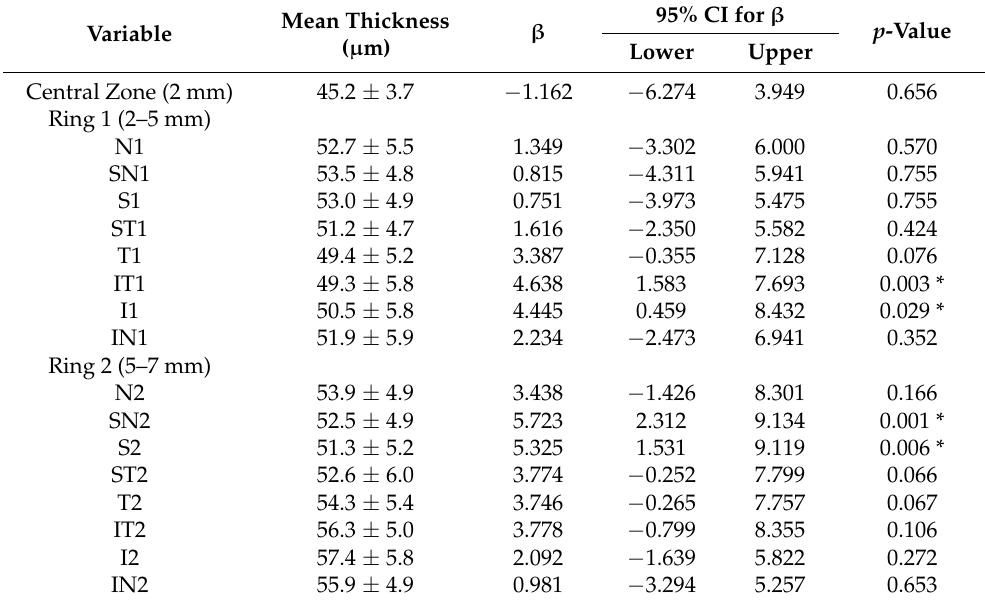
Table 2. Analysis between epithelial thickness and annual axial length